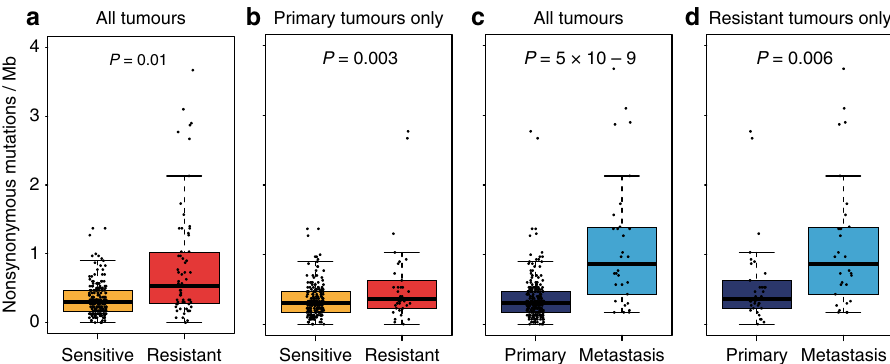
Fig. 2 Tumour mutation burden in TGCT. Box plot showing that tumour mutation burden (TMB) is higher in platinum-resistant tumours vs. platinum- sensitive/unselected tumours ( a , b ) and metastatic tumours vs. primary tumours ( c , d ). Analyses were performed on 269 tumours with exome sequencing data (from the ICR1, ICR2, DFCI, and TCGA sample series) after excluding those samples with missing histology and/or missing tumour purity estimate ( n = 20), and one sample with an excessively high TMB (DFCI_C13_T1) ( n = 269, a , c ). Analyses were also restricted to a subset of tumours comprising either only primary tumours ( n = 239, b ) or tumours from cases with platinum resistant disease ( n = 64, d ). Boxes show the median ± 25 – 75th percentiles, whiskers show 1.5× interquartile range below and above the 25th and 75th percentiles, respectively. p values are derived via two-sided multiple linear regression models adjusting for sample stage, histology, platinum response, dataset, and tumour purity.